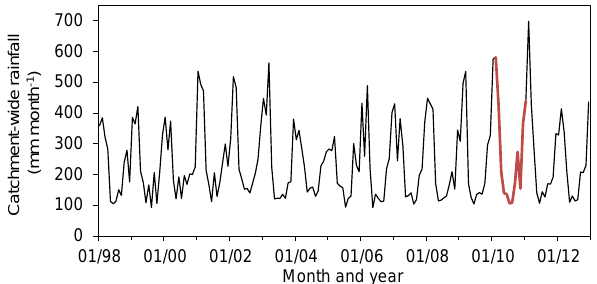
Figure 4. Catchment-wide TRMM calibrated rainfall for the Kosñi- pata catchment from 1998 to 2012. The thick red line represents the 1-year study